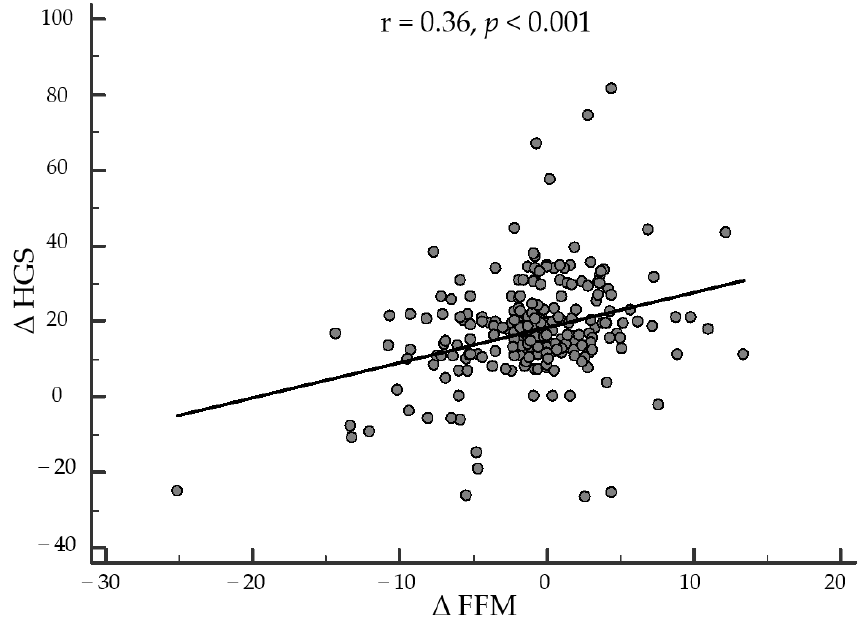
Figure 3. Correlation between changes in ∆ HGS and ∆ FFM after adjusting for ∆ BMI, ∆ WC, ∆ hs-CRP levels, and physical activity.